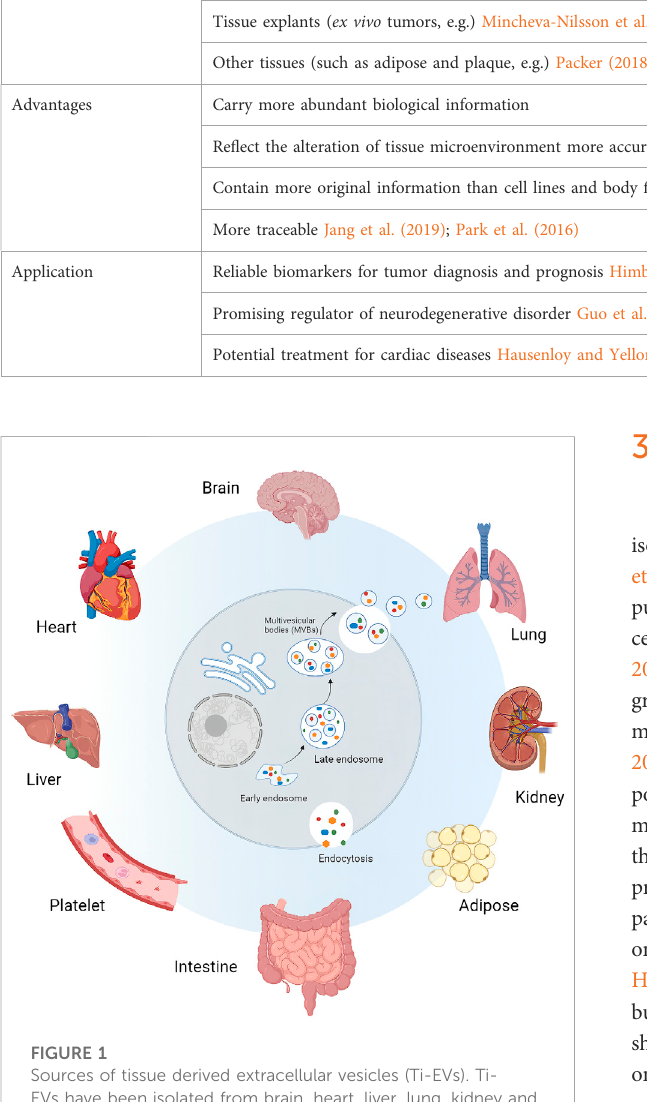
Sources of tissue derived extracellular vesicles (Ti-EVs). Ti- EVs have been isolated from brain, heart, liver, lung, kidney and intestine tissues, as well as adipose tissue and